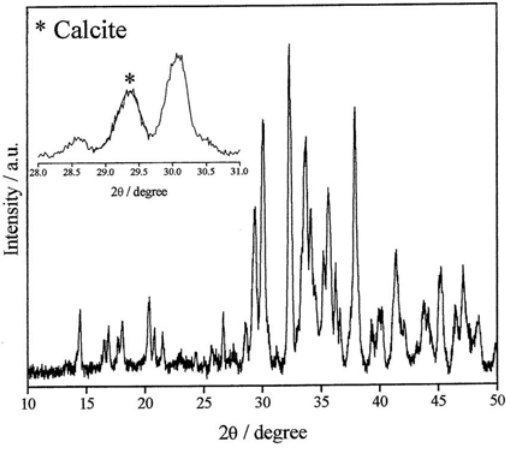
Fig. 4–PowderXRDpatternsofthecalciumcarbonateinorganic